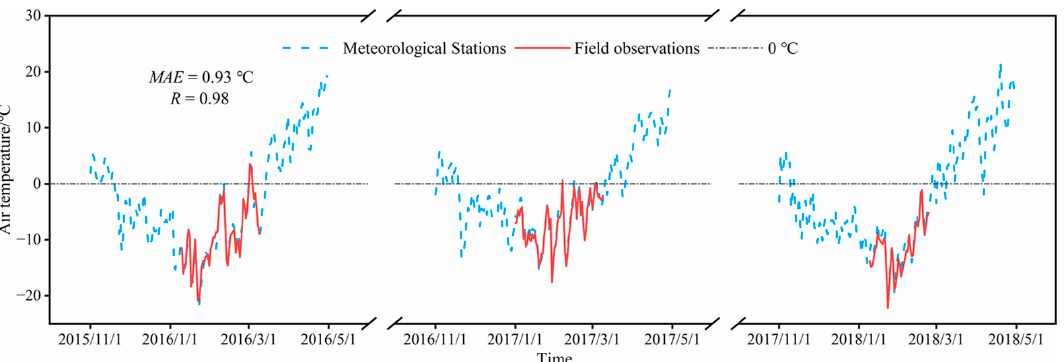
Figure 2. Comparison of daily mean air temperature between meteorological stations and field observations from 2016 to 2018. ( MAE is the mean absolute error, R is the correlation coefficient).